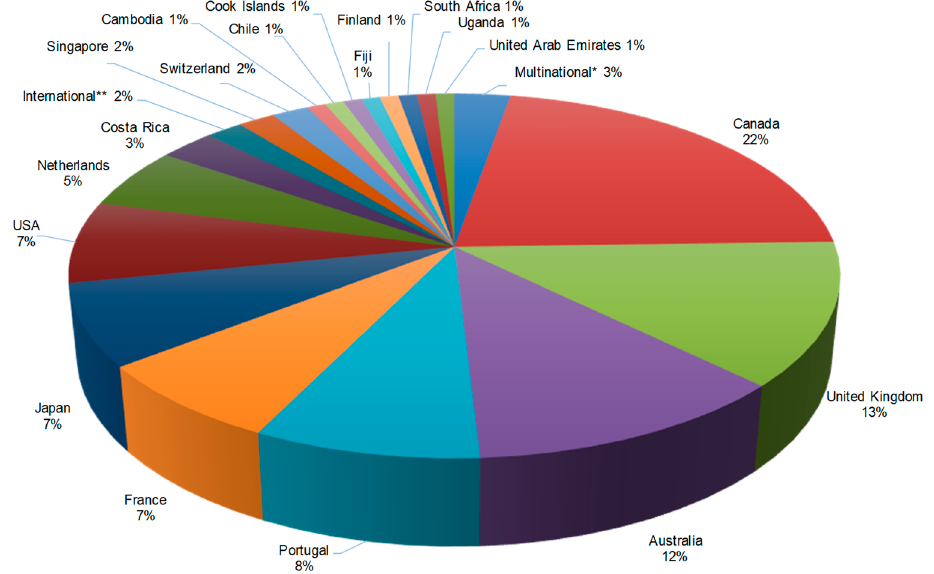
Figure 1. Summary of countries represented in survey. “Multinational *” includes two or more named countries. Additional countries affiliated with a survey respondent who self-identified as multinational in nature were not counted to avoid double counting. “International **” includes participants who self-identified their affiliations as “international” or “global” in nature and not to any single country or number of